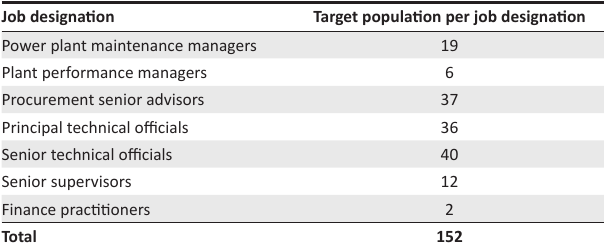
TABLE 1: Distribution of respondents by job designation.